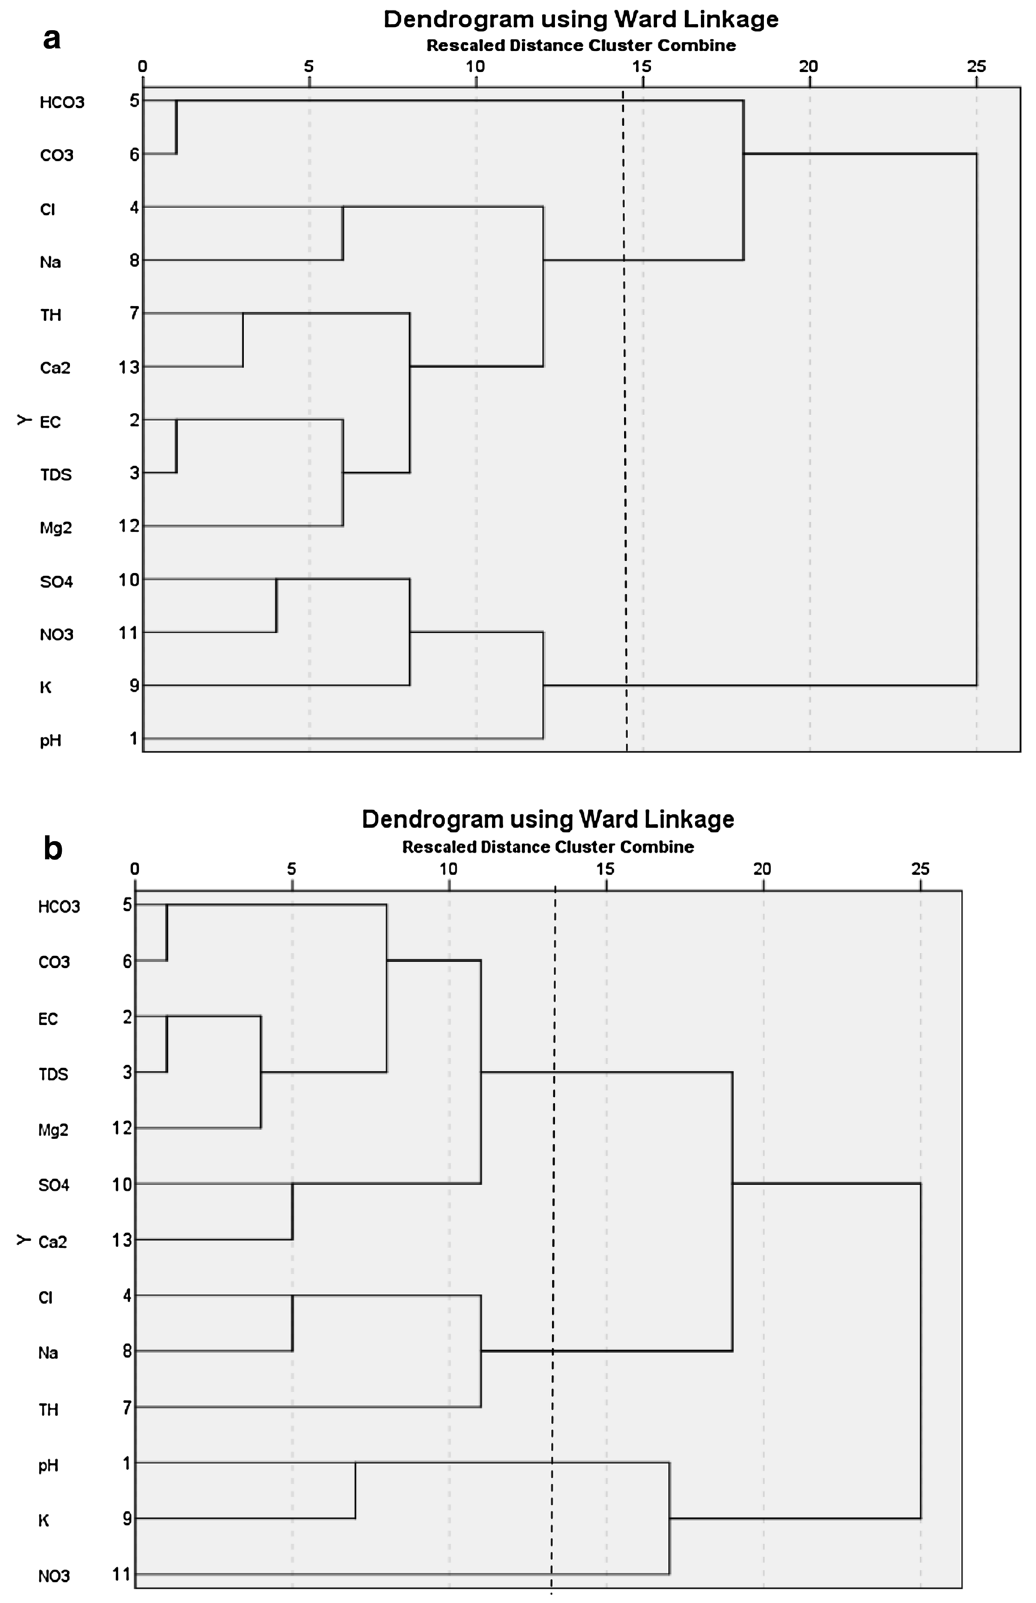
Fig. 5 a Dendrogram of analyzed parameters during dry season. b Dendrogram of analyzed parameters during wet